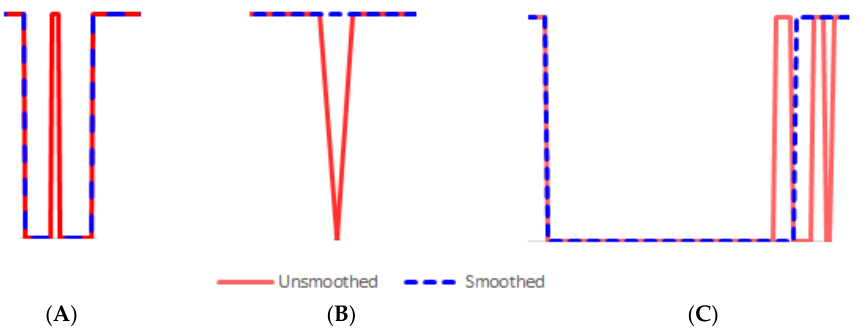
Figure 4. Curve smoothing. ( A ) A spike, ( B ) A dip, ( C ) An unsmooth maneuver.